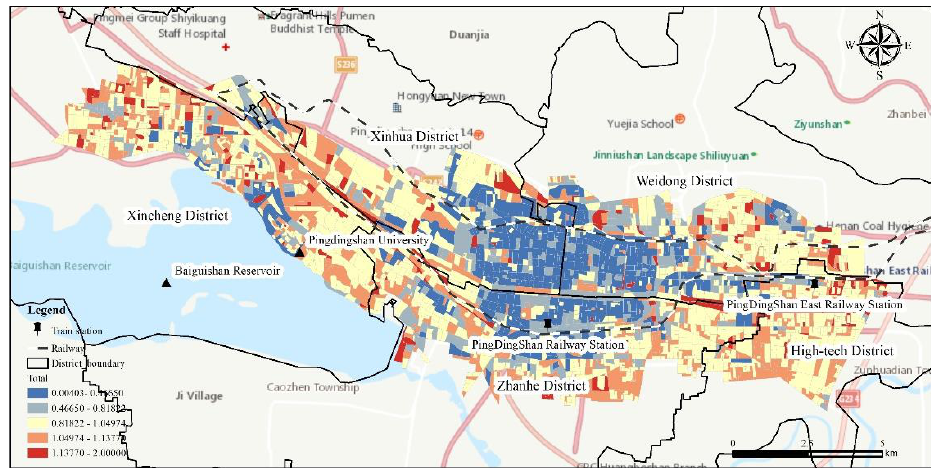
Figure 5. Visualization of comprehensive fragmentation in the built-up area of Pingdingshan city.